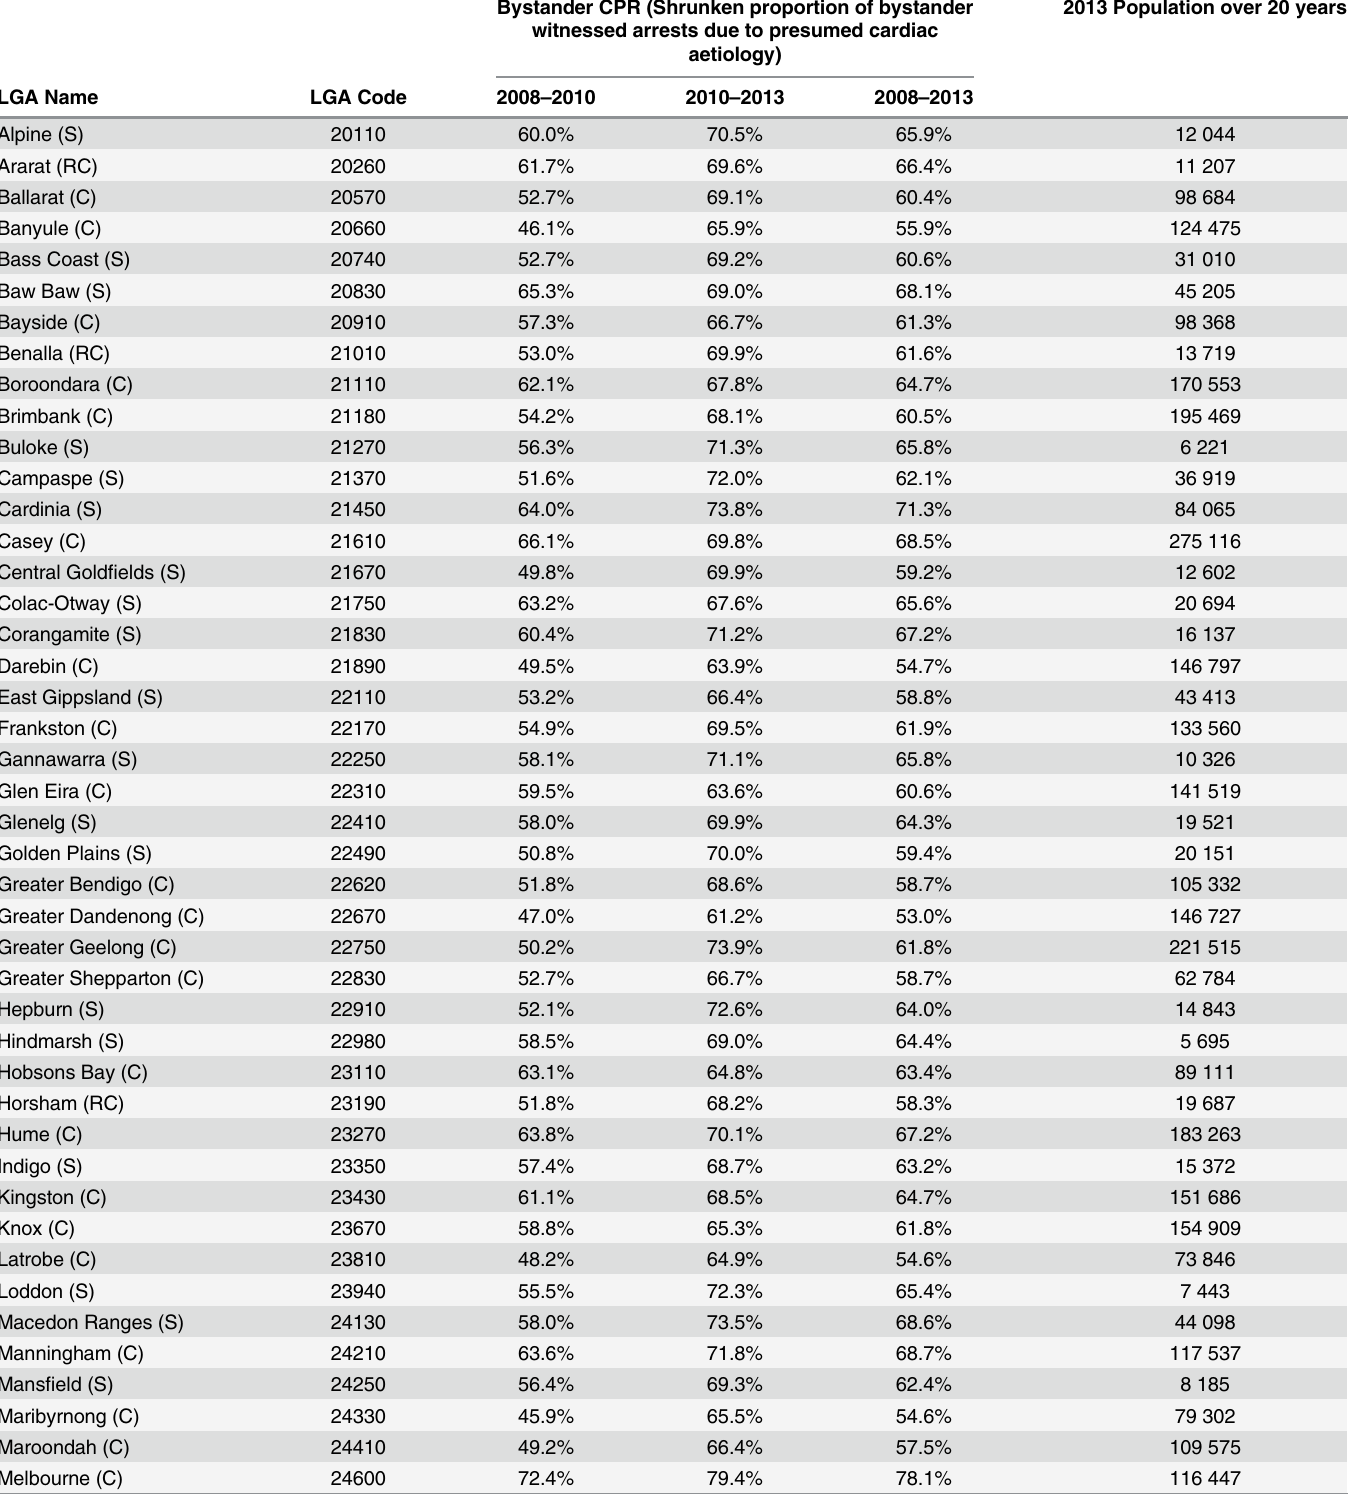
Table 2. Shrunken estimate of bystander CPR rate by Victorian Local Government Area, 2008 –